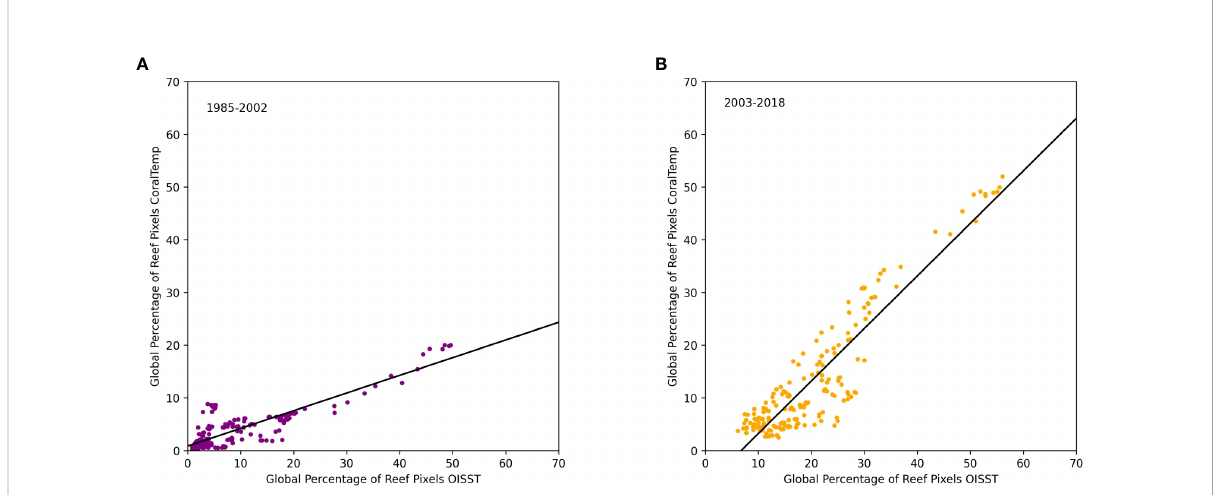
FIGURE 9 Global extent of heat stress (percentage of reef pixels) in the 5-km CoralTemp dataset and 25-km OISST dataset with an 8-month detection window for (A) 1985-2002; and (B) 2003-2018. Lines of best fi t